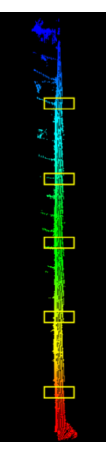
Fig 6. Slices for local diameter estimation